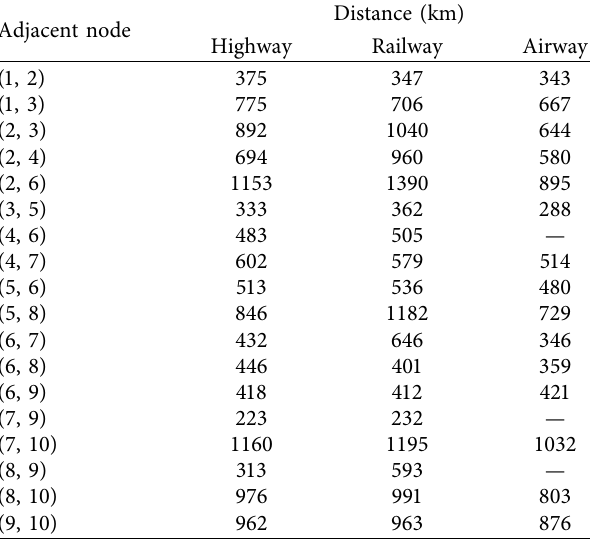
Table 3: Transport distance between node pairs. Adjacent node